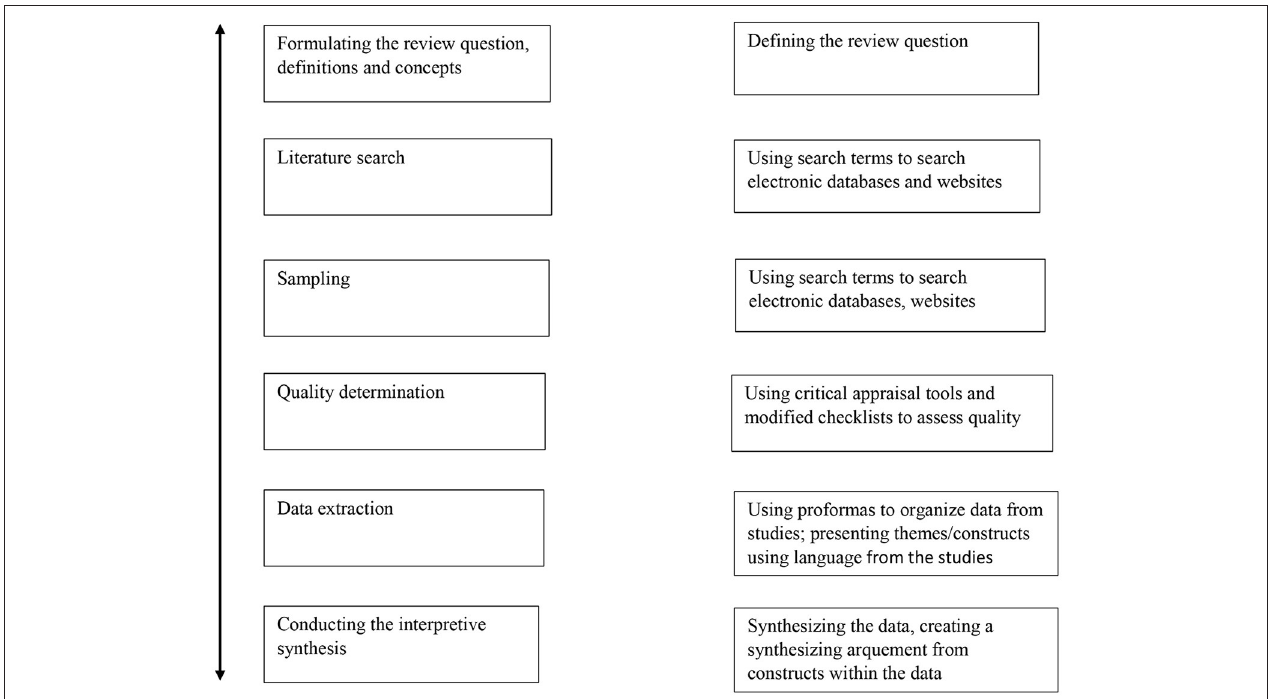
FIGURE 1 | Phases of the Critical Interpretive